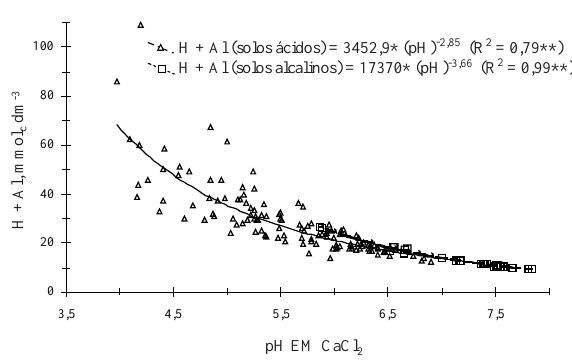
Figura 5. Relação entre a acidez potencial e o pH em CaCl em solos ácidos, tratados com 2 composto de lixo, na presença ou ausência de calcário dolomítico e adubos minerais, e em solos alcalinos, em que o calcário foi substituído por